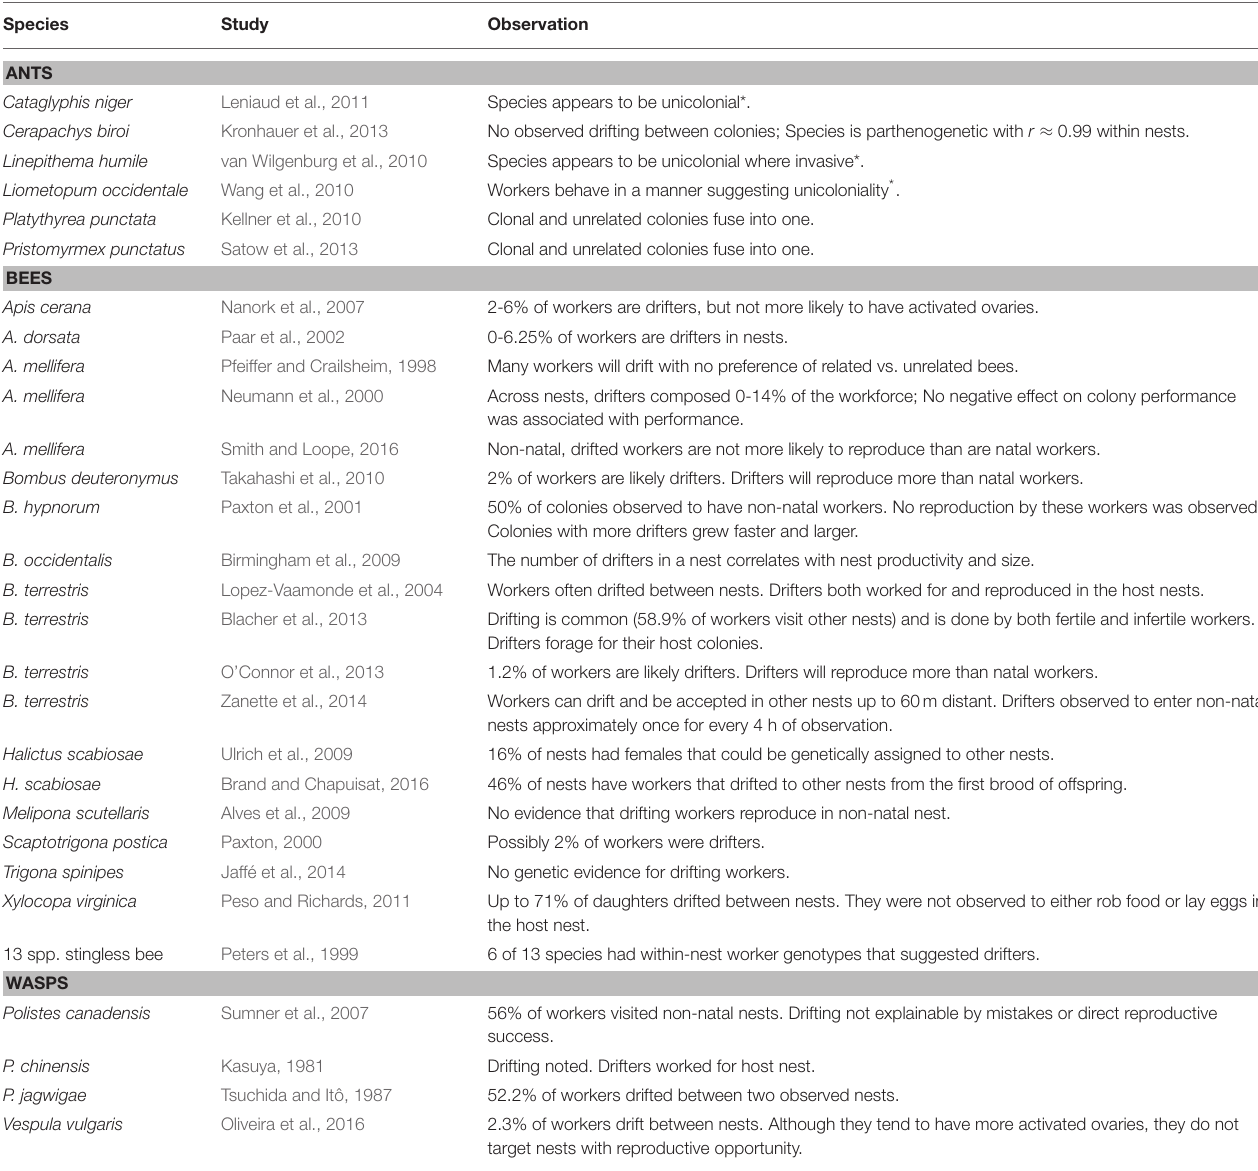
TABLE 1 | Species with measured levels of drifting workers across reproductively viable nests. Species Study